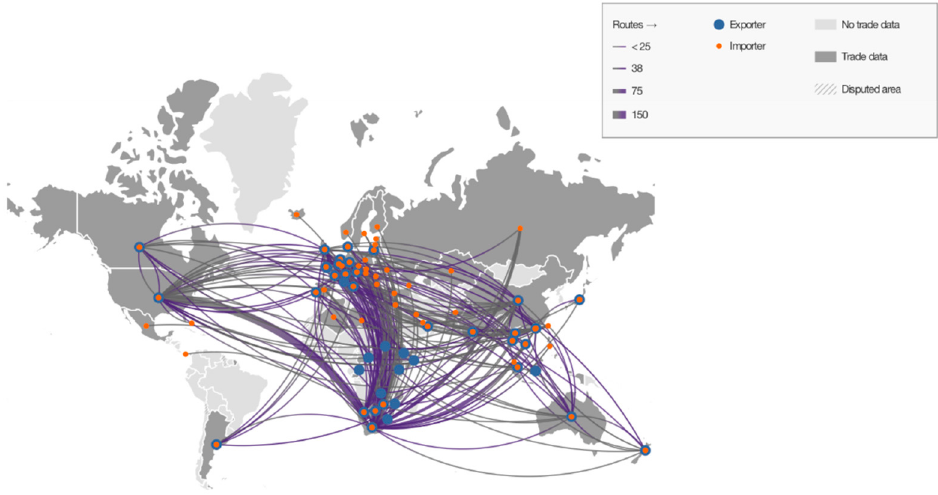
Figure 3. Aggregated routes of rhino trade cases, 2007–2017 (The CITES Trade Database).